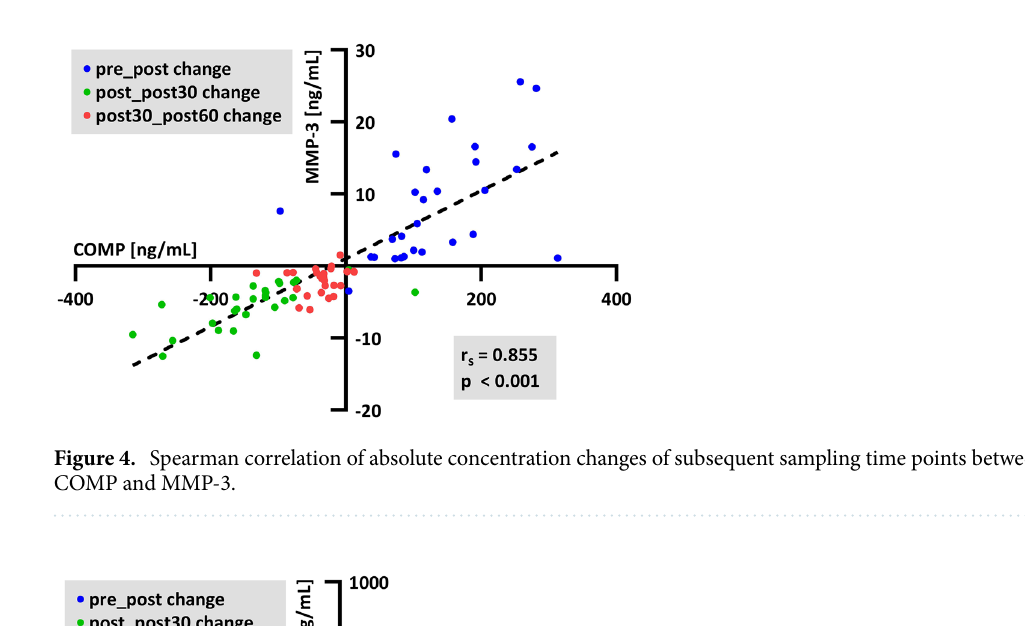
Figure 3. Spearman correlation matrix of absolute concentration changes of subsequent sampling time points. All presented coefficients are significant ( p < 0.05).